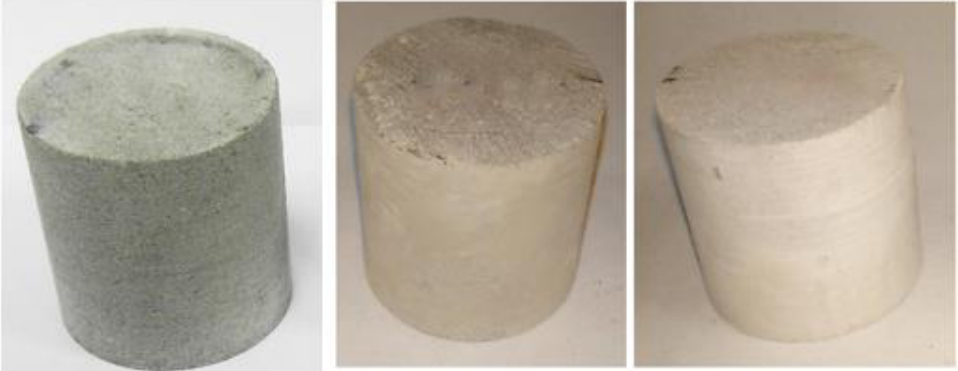
Figure 4. Examples of rock samples for physical and mechanical property tests.